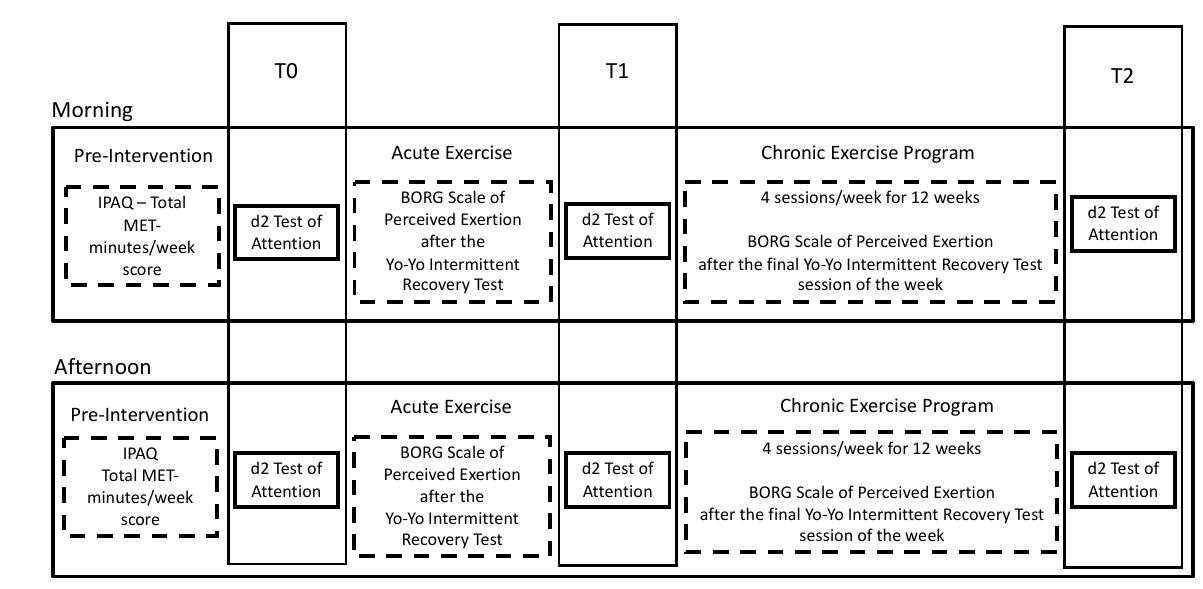
Figure 1. Research design timeline.